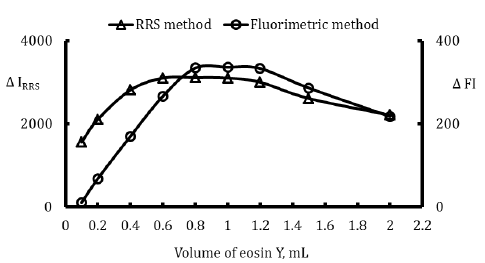
Figure 6: Effect of eosin Y volume (3.7 ´ 10 - 5 M) on the fluorescence quenching effect and RRS enhancement of the association complex formation with cyclobenzaprine (1.0 μg/mL).